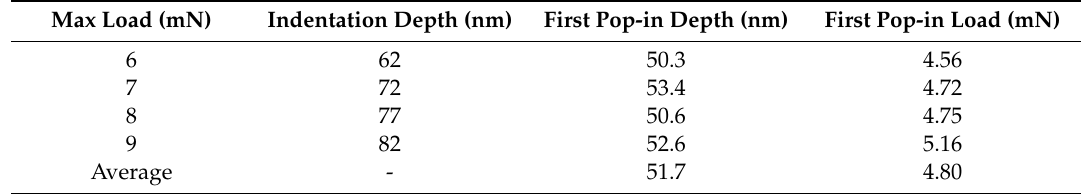
Table 1. The critical indentation depth and critical force for the plastic–brittle transition.